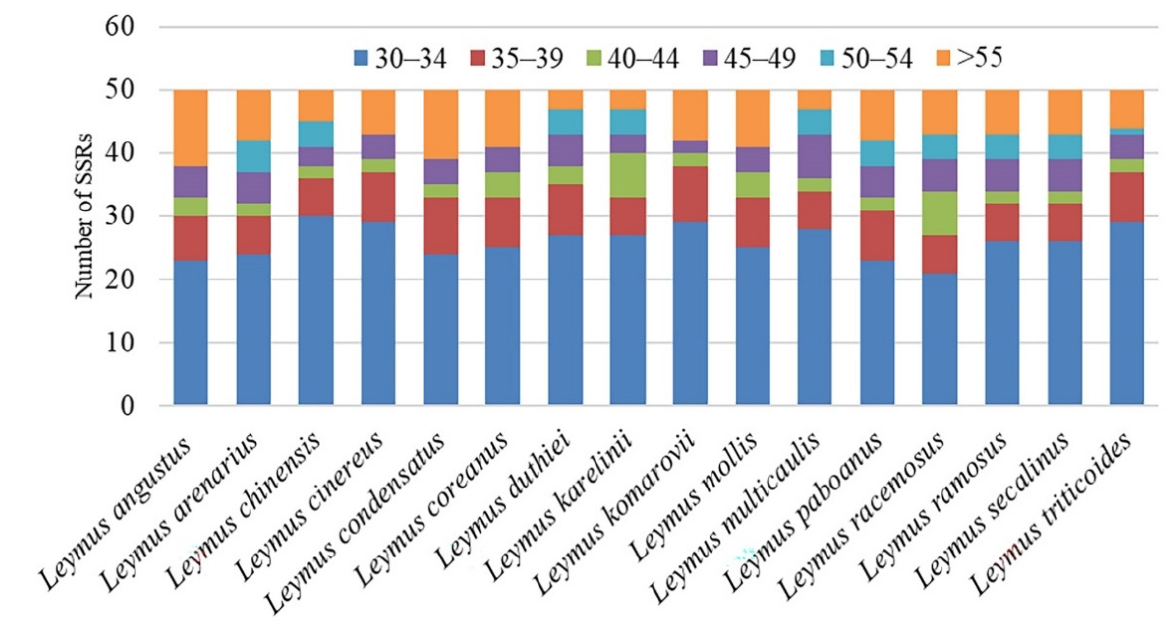
Figure 3. The number of repeats with different lengths in the 16 Leymus cp genomes. The number of SSRs was not significantly different among the 16 Leymus cp genomes analyzed, ranging from 36 in L. duthiei to 50 in L. coreanus (Table 1). LSC was the region with more SSRs (mean 2.39 SSRs per kb), followed by the IR (mean 8.44 SSRs per kb) and SSC (mean 4.21 SSRs per kb) regions. Only two SSRs were located in the IRs ( rrna4.5 ) of L. angustus , L. condensatus , and L. mollis , and the remaining species had 6–10 SSRs in the IR region (Figure 3, Table 1). Within the cp genomes of the 16 Leymus species, 56.76% and 67.35% SSR loci were found in the intergenic areas of L. mollis and L. karelinii , respectively. Moreover, the gene-coding regions of L. karelinii and L. racemosus had 20.41% and 27.03% SSR loci, and 11.11% and 16.67% SSR loci were found in the intron areas of L. duthiei and L. chinensis. (Table S5). What is needed to pay attention to is that SSR located in